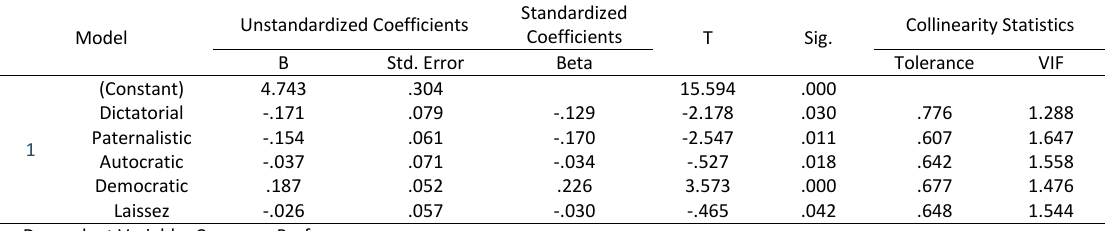
Table 3: Multiple Regression– Coefficient